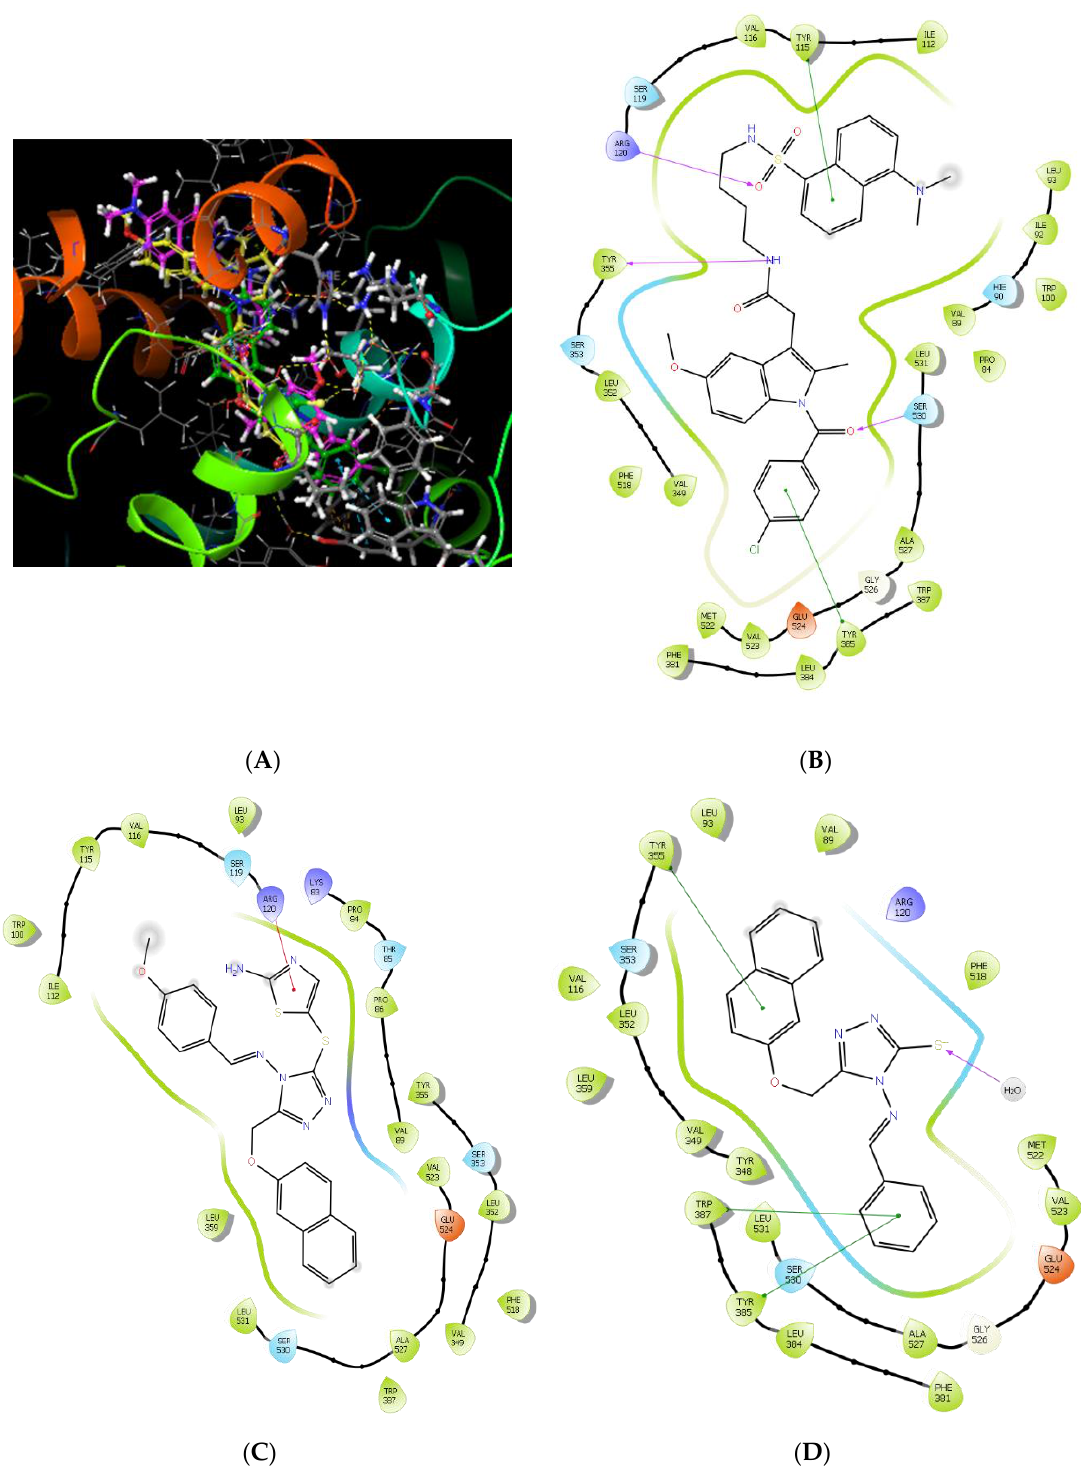
Figure 6. ( A )Three-dimensional-binding modes and overlay of Dansyl-Indomethacin, compounds 9a and 12d in the catalytic domain of COX-2 (PDB 1M17). ( B ) 2D of dansyl-indomethacin, ( C ) 2D of compound 12d , and ( D ) 2D of compound 9a in COX-2 catalytic domain.